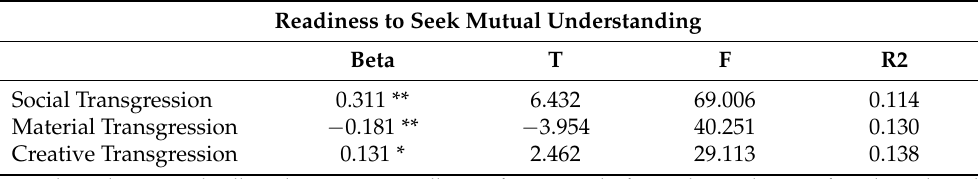
Table 3. Regression analysis of the Transgression dimensions which explain Readiness to Seek Mutual Understanding (N = 528).